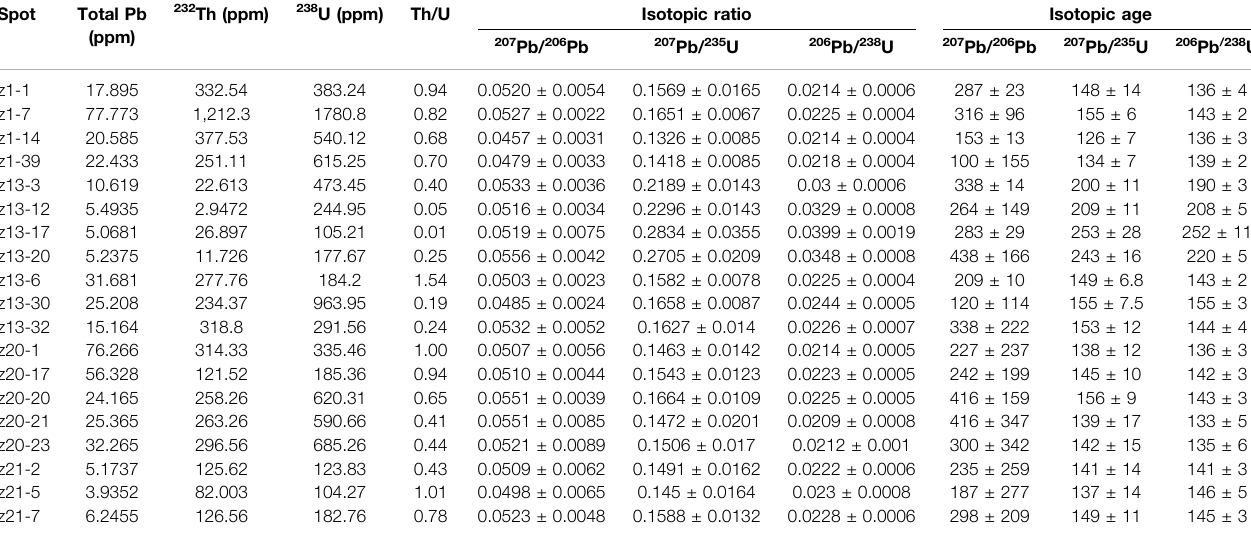
TABLE 6 | LA-ICP-MS zircon dating results for the Zhaoxian gold deposit.